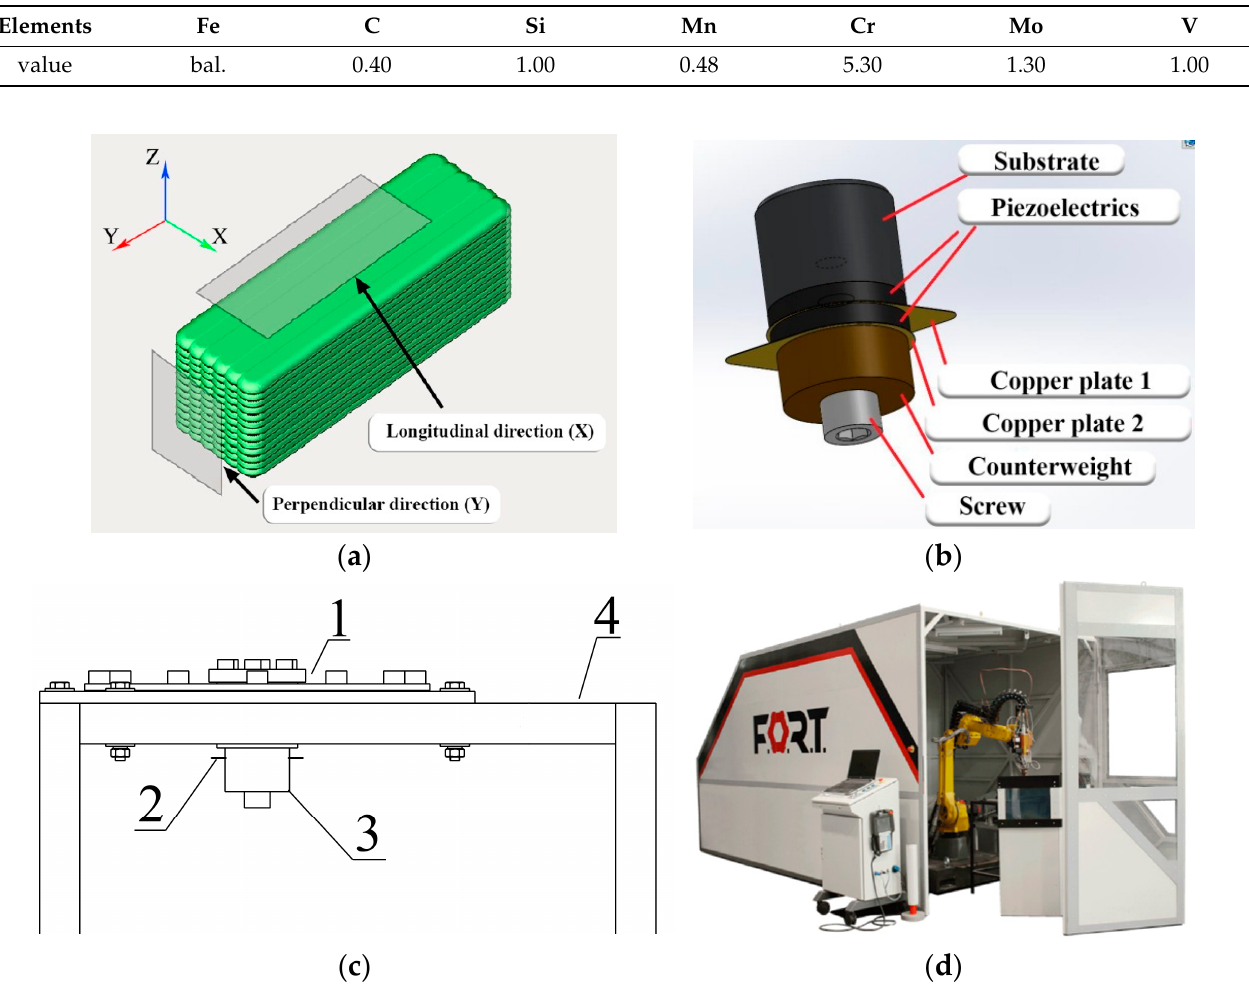
Figure 3. ( a ) Sample showing the multitrack printing strategy; ( b ) layout of the substrate with US-assisted L-DED; ( c ) scheme of the US substrate device, where 1 is the front side with a substrate for cladding, 2 is the cooling circuit, 3 is the bottom of the case with the piezoelectrics, and 4 is the working table; ( d ) the image of the experimental setup.